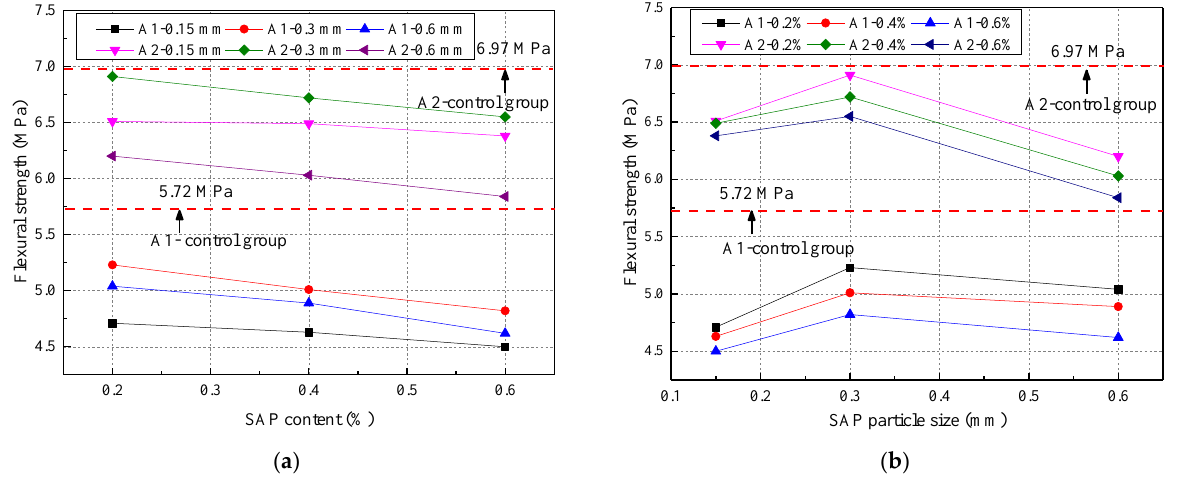
Figure 5. Flexural strength under different water–cement ratios: ( a ) different SAP content; ( b ) different SAP particle size.